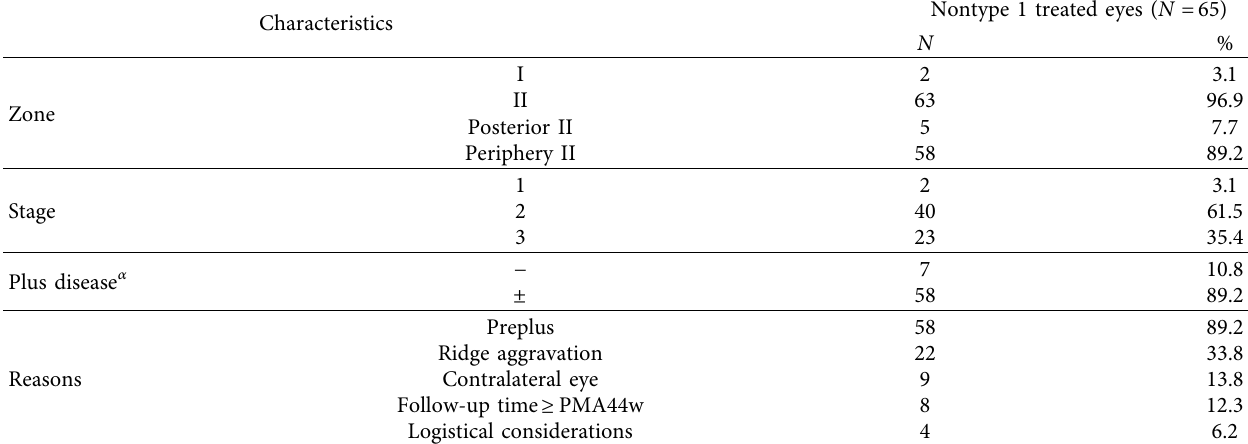
Table 3: Characteristics of pathological manifestation of nontype 1 ROP receiving treatment.